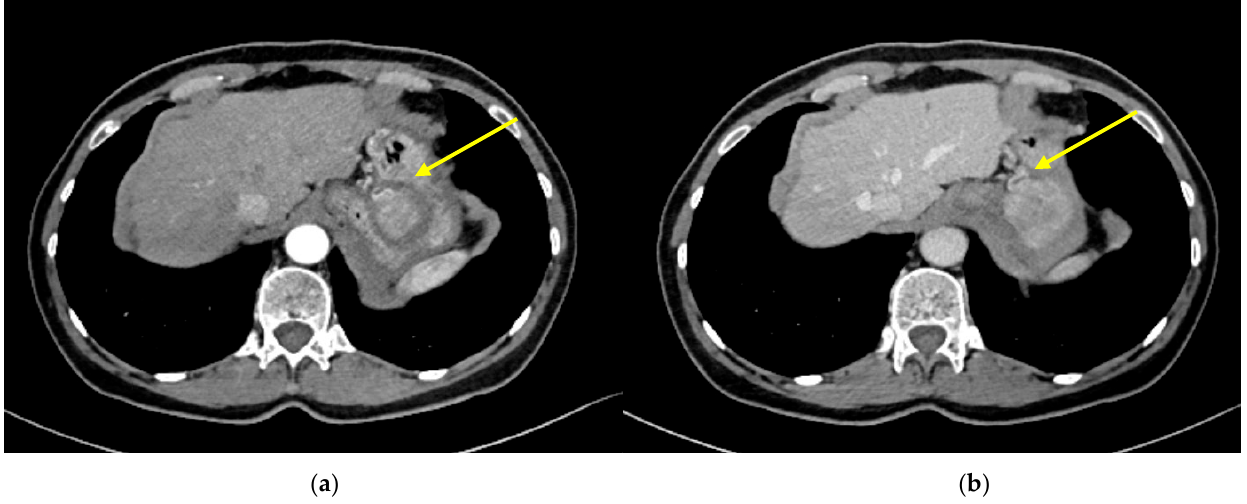
Figure 1. Axial contrast-enhanced computed-tomography (CT)-scan images: ( a ) arterial phase; ( b ) portal phase. Arrow: ovaloid-shaped solid mass.